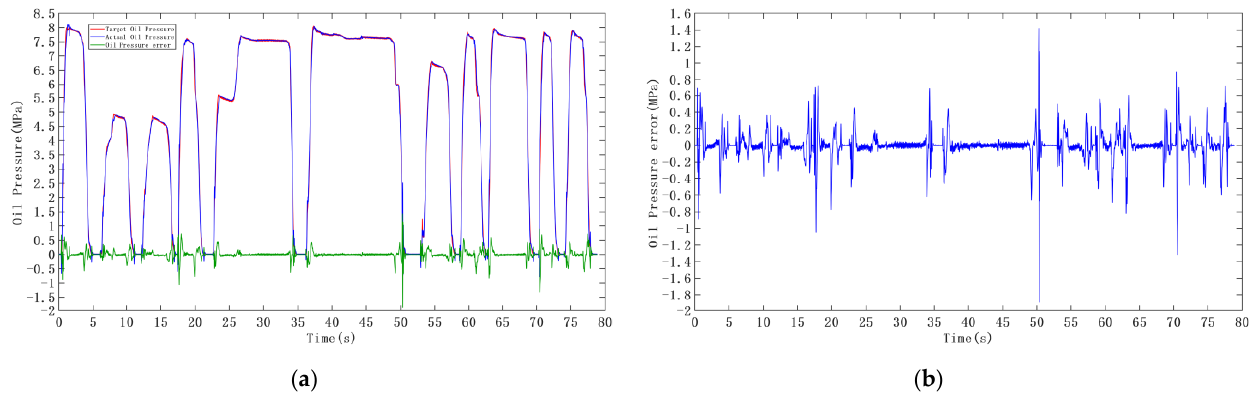
Figure 20. Results of oil pressure following control based on traditional PID controller under emergency braking conditions: ( a ) Target oil pressure, actual oil pressure and oil pressure error. ( b ) Oil pressure error.